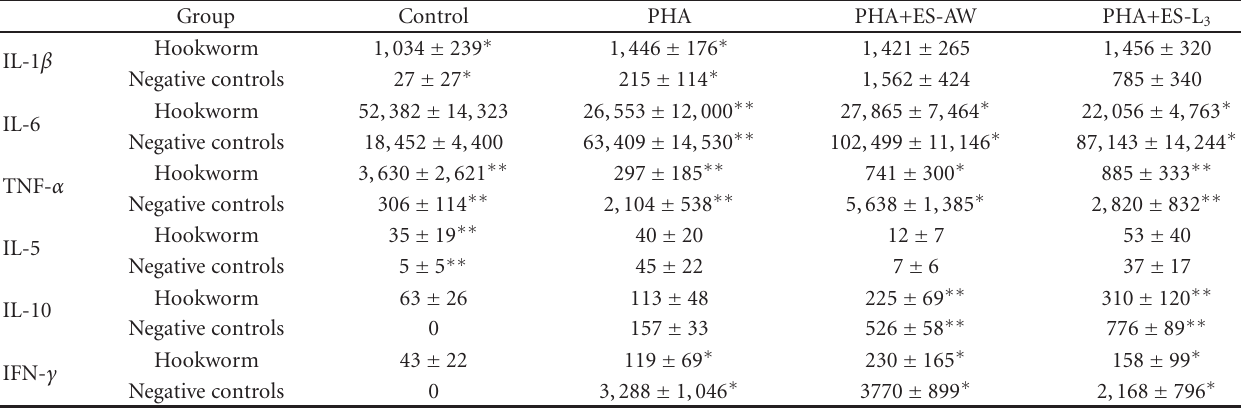
Table 1: Cytokine concentrations (pg/mL) in supernatants from PHA-stimulated PBMC cultures with or without costimulation by adult worm ES (ES-AW) or third-stage larval ES (ES-L 3 ) antigen. Values from hookworm-infected individuals ( n = 7) and negative controls ( n = 6) are compared and indicated as mean values ± standard errors. Significant di ff erences between groups are indicated with an asterisk ( ∗ P < . 01; ∗∗ P < . 05).